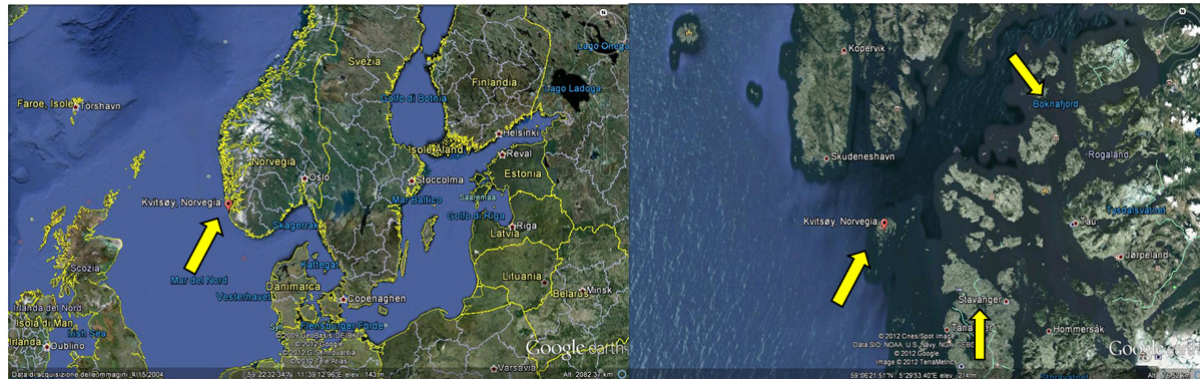
Figure 2. The Kvitsøy